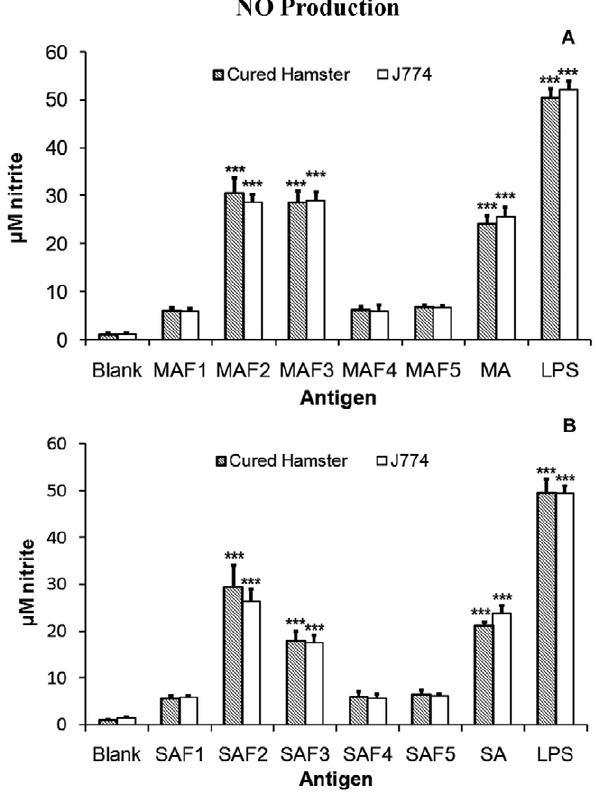
Figure 8. Nitric oxide production ( m M) by peritoneal macro- phages of hamsters (n=9) and J774 cell lines in response to MA (A) and SA (B) at 10 m g/ml after 24 h stimulation. The absorbance of the reaction product was measured at 540 nm using Griess reagent.